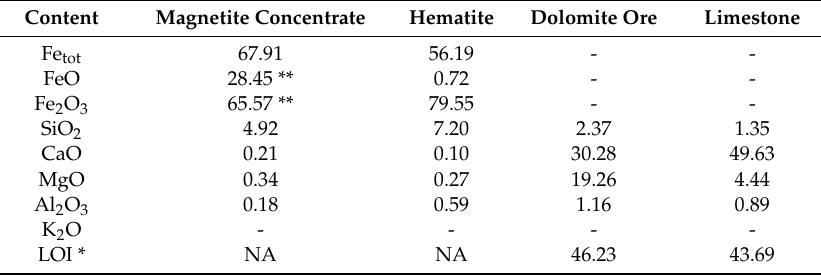
Table 1. Chemical composition of raw materials (dry basis) / wt%.